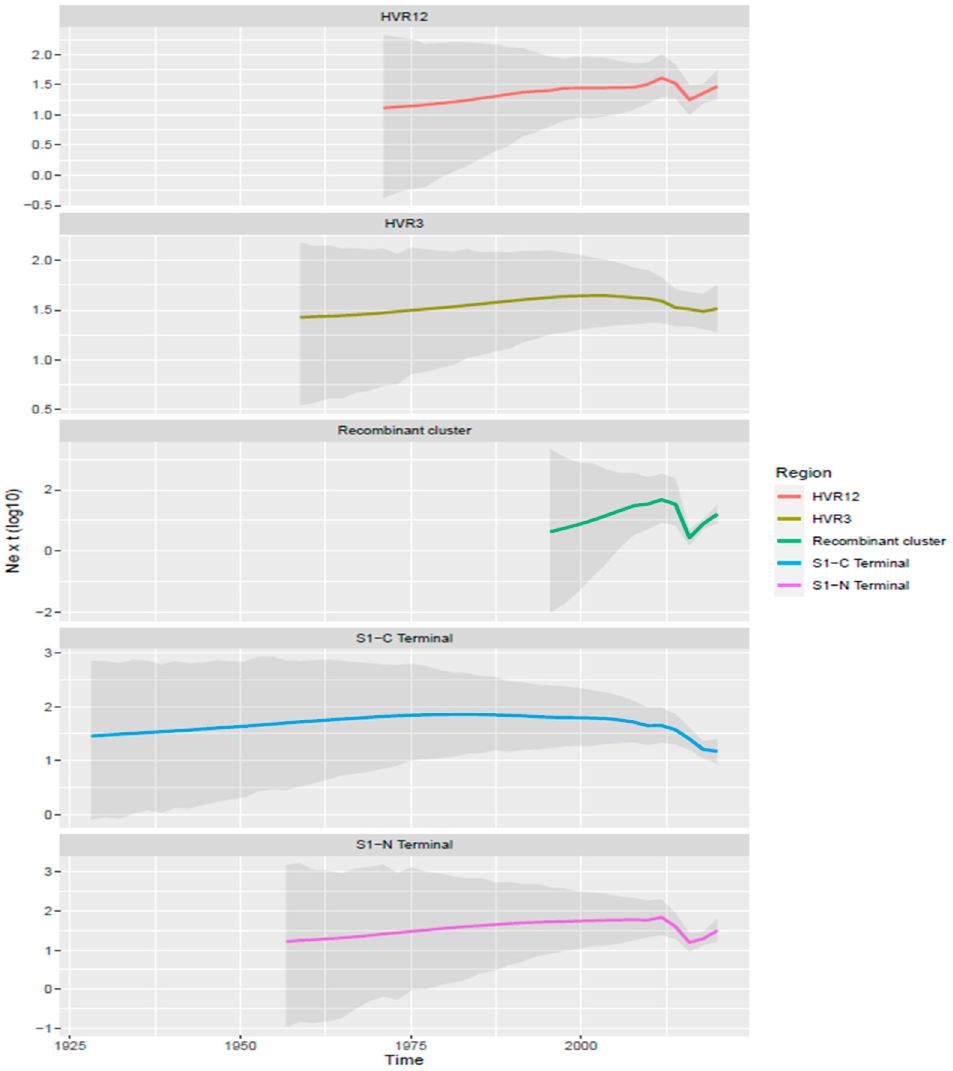
Figure 3. Skygrid reconstruction of GI-23 population dynamics over time. The mean value of relative genetic diversity (Ne ∙ t) is depicted by a continuous line, while shaded areas represent the 95HPD intervals. Different datasets have been color-coded and facetted.